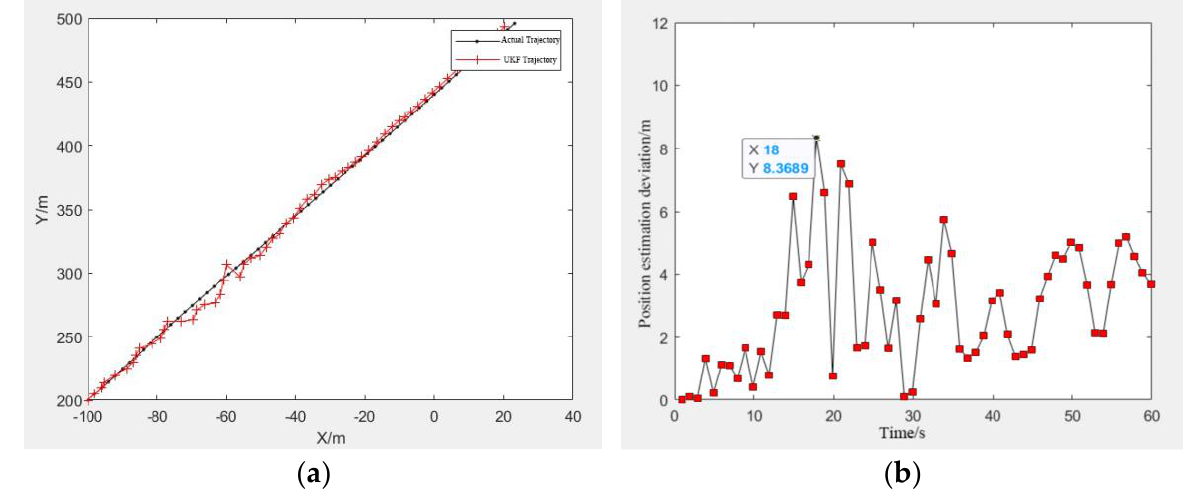
Figure 14. Target tracking result based on UKF algorithm. ( a ) Predicted trajectory based on UKF. ( b ) The estimated deviation.